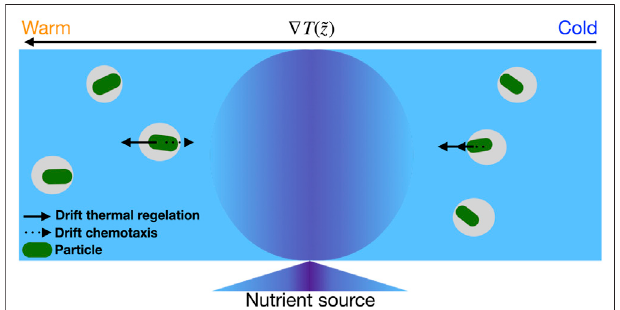
FIGURE 1 | Schematic of few active particles embedded in ice under an external temperature gradient ∇ T along the ~ z -axis. The nutrient source is shown by the purple gradient. The external temperature gradient induces a driftvelocity,andparticlesmovetowardregionsofhighertemperature,in a process known as thermal regelation (black arrow). An additional drift velocity is associated with particle motion towards higher concentration of nutrients (black dotted arrow). Thus, depending on a particle ’ s position, and the background temperature and nutrient gradients, these two drift effects can compete or amplify each